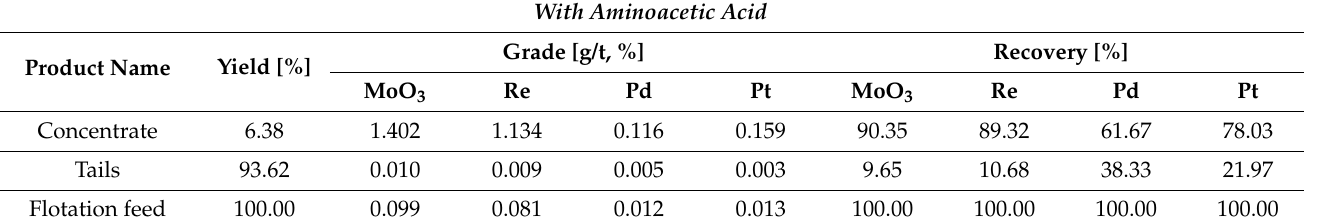
Table 11. Results of DOS flotation with and without aminoacetic acid. Without aminoacetic acid